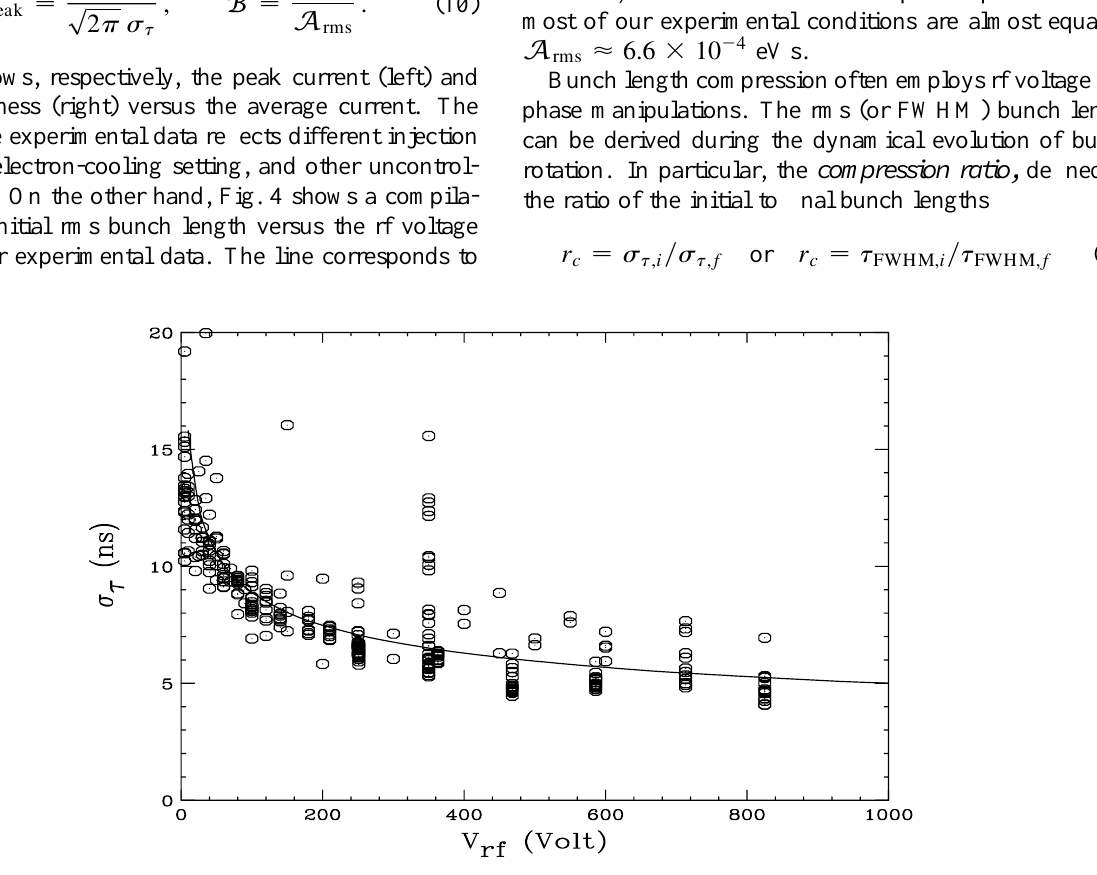
FIG. 4. Compilation of rms bunch length versus initial rf voltage of a cooled beam in the IUCF cooler ring. The line corresponds (cid:1) 4 to a fit with s t (cid:1) 28.1 (cid:1) V 1 rf ns, where V rf is measured in